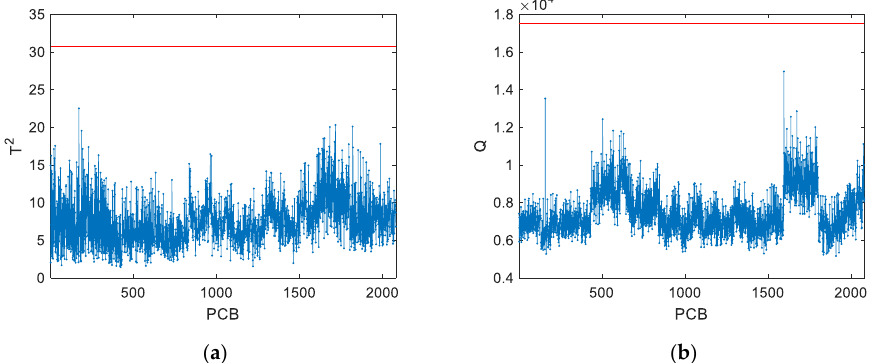
Figure 14. Control charts for the PCBs in CS2: ( a ) T 2 -statisctic; ( b ) Q -statistic.